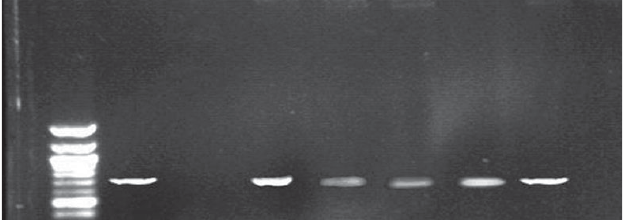
Fig. 1 - Gel documentation of TTV-positive samples Lane 1 mol wt marker – 50 bp. Lane 2 Positive control. Lane 3 Neg control. Lane 4 – 8 positive samples. Lane 9 negative